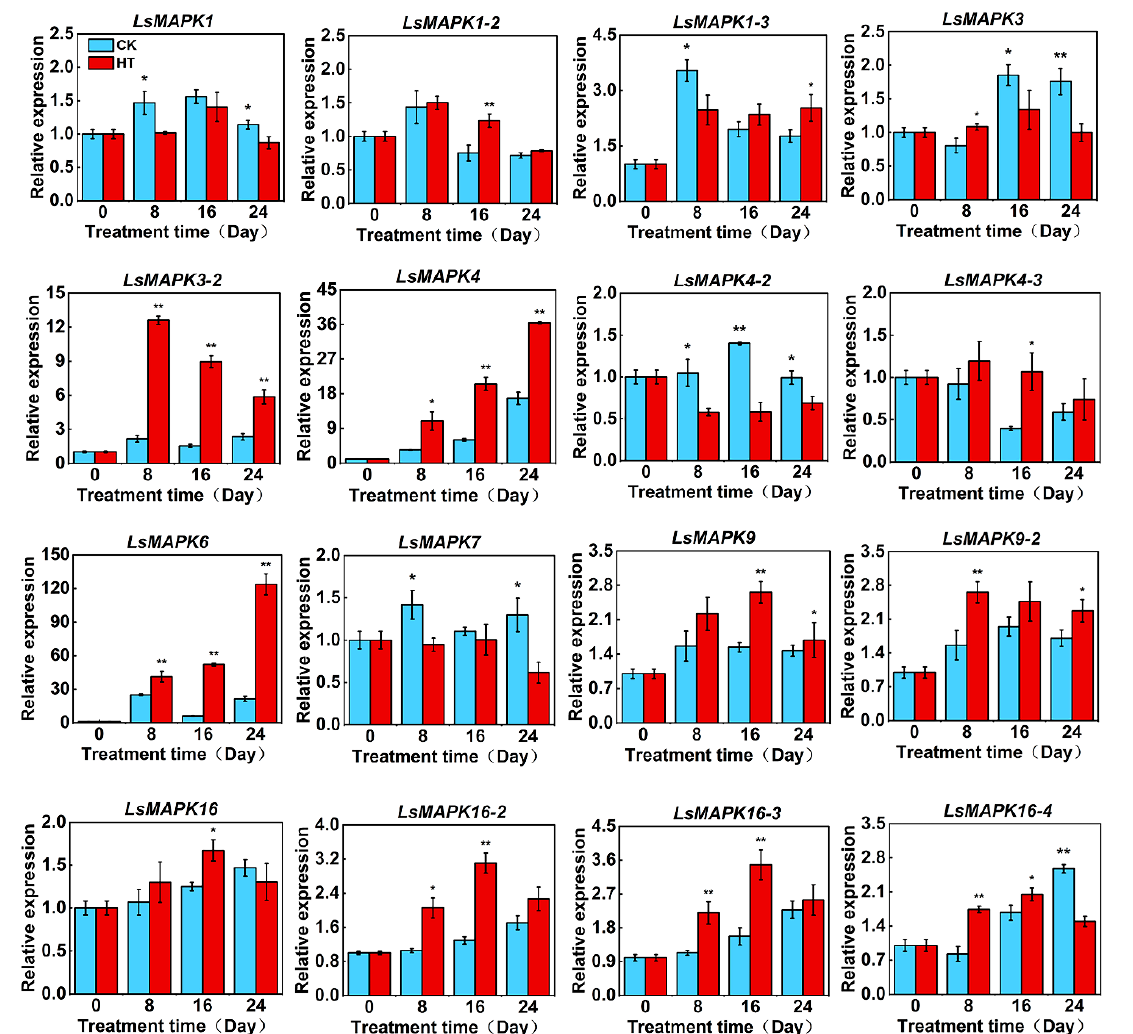
Figure 9. Expression analysis of LsMAPKs in lettuce under high temperature. HT, high temperature. The standard error is indicated, * stands for p < 0.05, and ** stands for p < 0.01. The standard error is indicated, * stands for p < 0.05, and ** stands for p <